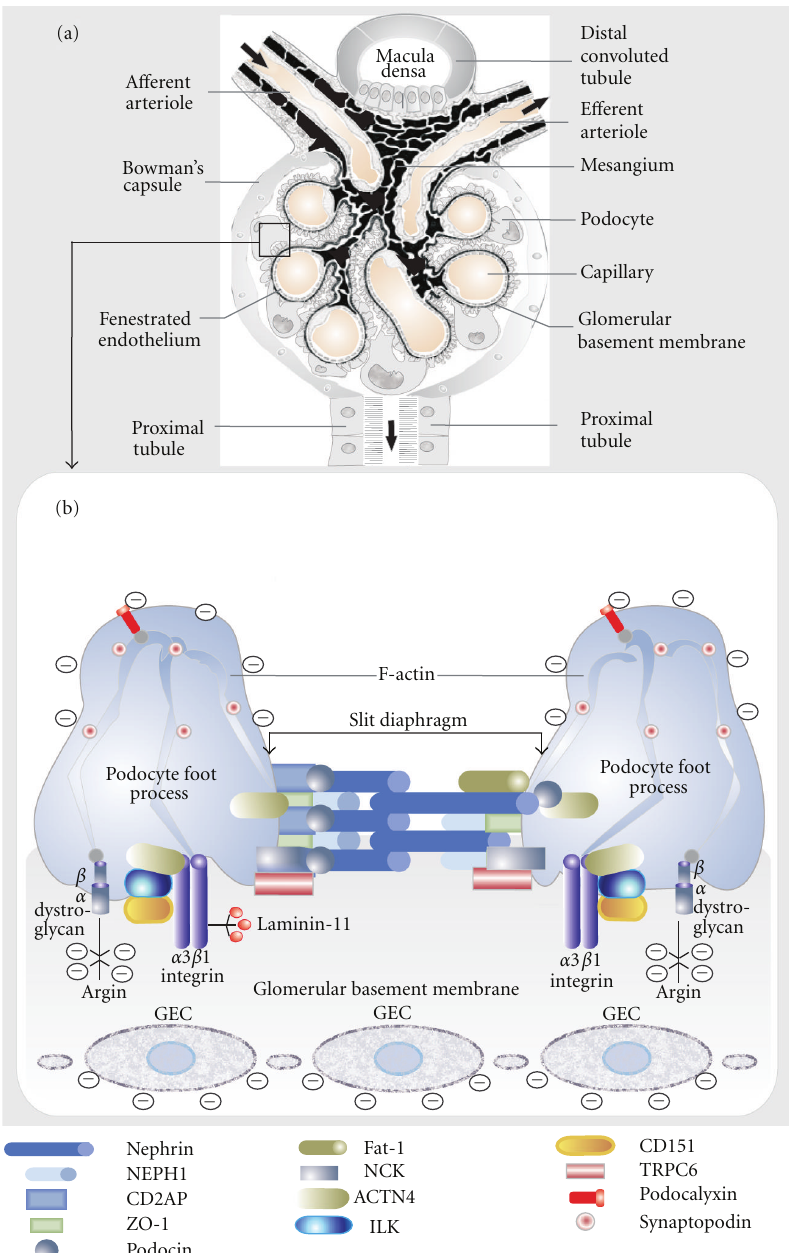
Figure 1: Schematic representation of glomerular filtration barrier components. (a) Illustration of all participant structures in the normal glomerular filtration process. The rectangle indicates the tight relationship between the glomerular capillary wall, glomerular basement membrane, and glomerular visceral epithelial cell (podocyte) which is detailed in the lower panel. (b) Molecular structures of the podocyte and slit diaphragm. Abbreviations: ACTN4: α -actinin-4; CD2AP: CD2-associated protein; GEC: glomerular endothelial cell; ILK: integrin- linked kinase; ZO-1: tight junction protein ZO-1; CD151: tetraspanin CD151; TRPC6: transient receptor potential cation channel 6; NCK: protein adaptor